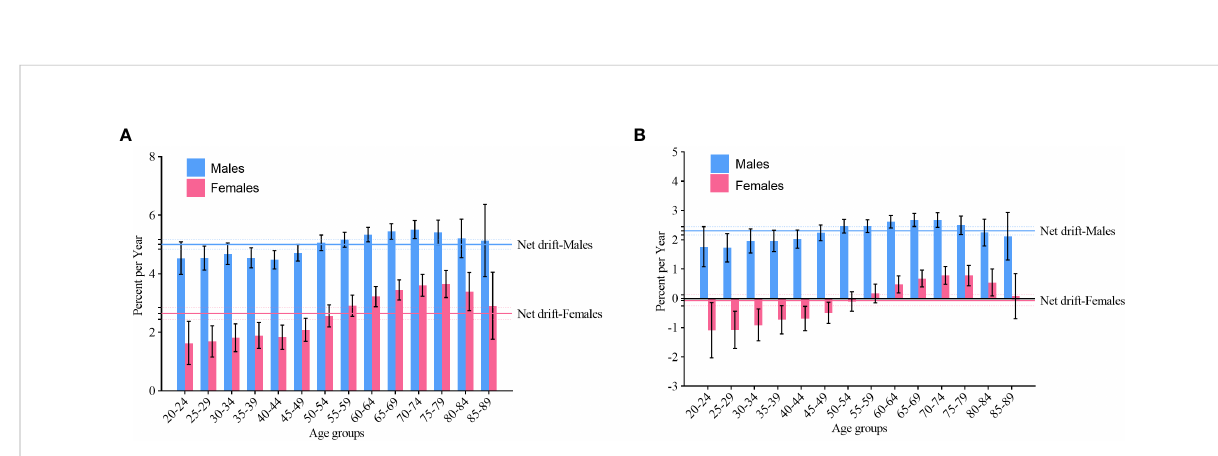
FIGURE 3 Net drift and local drift values of non-Hodgkin lymphoma by gender in China. (A) incidence; (B) mortality.